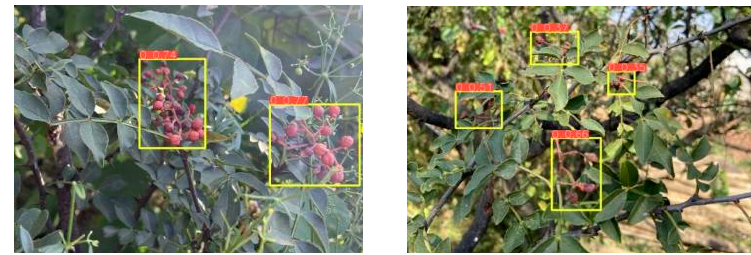
Figure 14. Detection effect of ripe prickly ash fruit in the field.